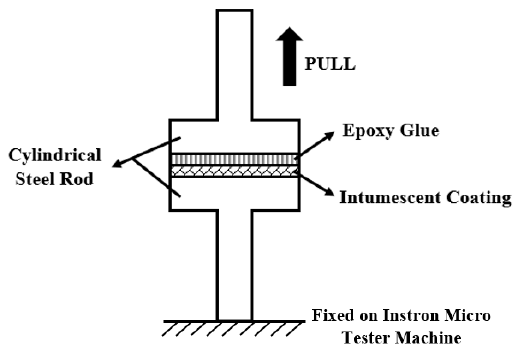
Figure 3. Schematic of the experimental setup for adhesion strength.